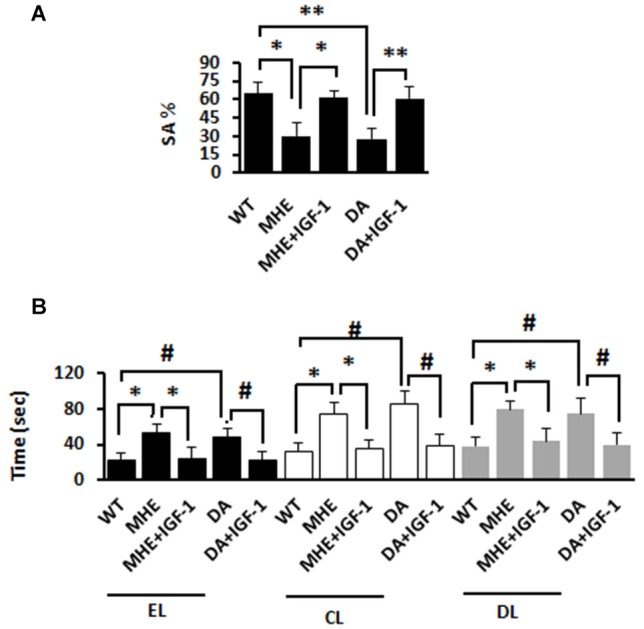
IGF-I improves memory impairment in MHE and DA-treated rats. (A) Y-maze test of MHE rats (n = 13) or DA-treated rats (n = 10) with or without IGF-I administration (spontaneous alternation percentage, SA%). (B) Water-finding task of MHE rats or DA-treated rats with or without IGF-I administration (EL, entry latency; CL, contacting latency; DL, drinking latency). Data are shown as mean ± SD. *P < 0.05, **P < 0.01, #P < 0.05.